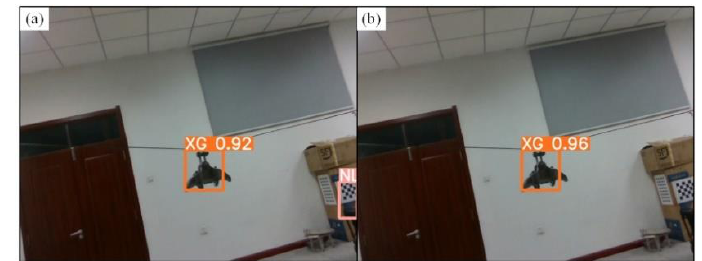
Figure 15. Visualization of feature maps and depth-attention matrices. ( a ) Input image of the test dataset. Depth-attention matrix, g ( x ), on the feature map of the last layer: ( b ) g ( x ) of large target recognition, ( c ) g ( x ) of medium target recognition, ( d ) g ( x ) of small target recognition. Feature heat map of the last layer at the standard YOLOv5 inference: ( e ) correct inference, ( f ) false inference. Feature heat map of the last layer at the depth-attention YOLOv5 inference: ( g ) correct inference, ( h ) false inference.